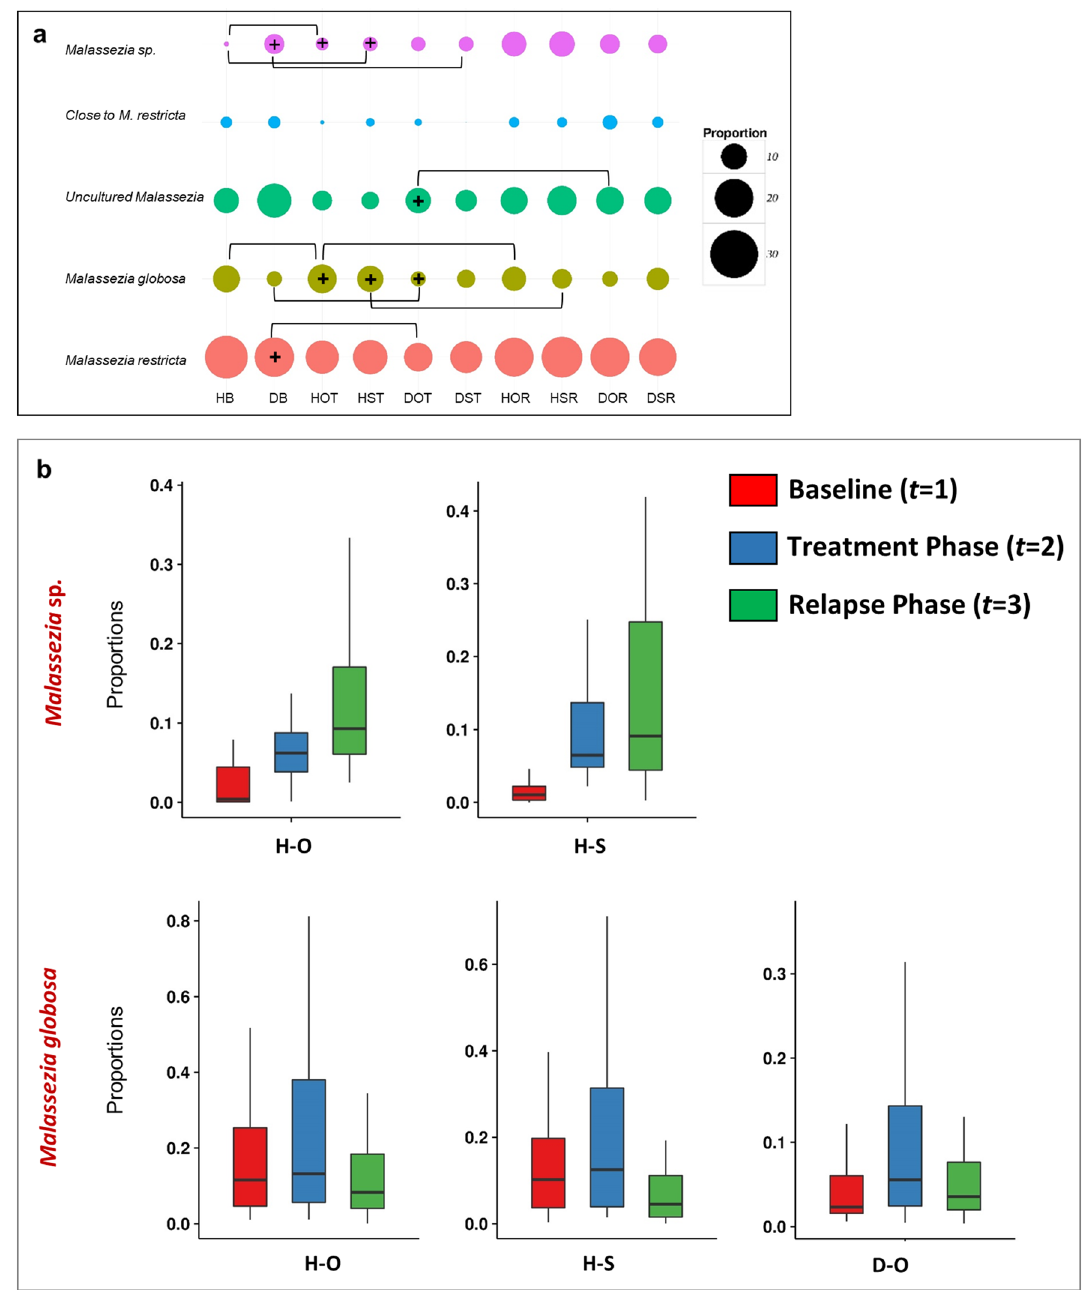
Figure 2. Comparison of fungal population at the three phases. ( a ) Bubble plots representing the top five fungal species across all the groups. The bubble size indicates mean relative abundance of species within each group. Square brackets indicate the groups between which a significant difference in the species abundance was observed ( p ≤ 0.05, Wilcoxon test, + indicates the group with the higher abundance among the two). ( b ) Core fungal species showing significant variations across the three phases (FDR adjusted p ≤ 0.05, repeated measures fungal species to show significant fold-changes between the groups and hence, the results only from the bacterial microbiome are included here. Among the other species, Corynebacterium sp., showed the maximum level of fold-change (from < 5 to > 20 times, p ≤ 0.05) after oil-treatment. Repeated measures ANOVA (FDR adj. p ≤ 0.05) confirmed an increase in the abundance of C. acnes in healthy subjects after oil-treatment (Fig. 3c, Table S1b). Changes in the proportion of C. acnes and S. epidermidis were retained ( p ≥ 0.05) after the relapse phase (Fig. 3c and Fig. S6). These results suggest an apparent beneficial effect of coconut oil on the core bacterial species after 12 weeks treatment, which appears to be retained at the relapse phase.